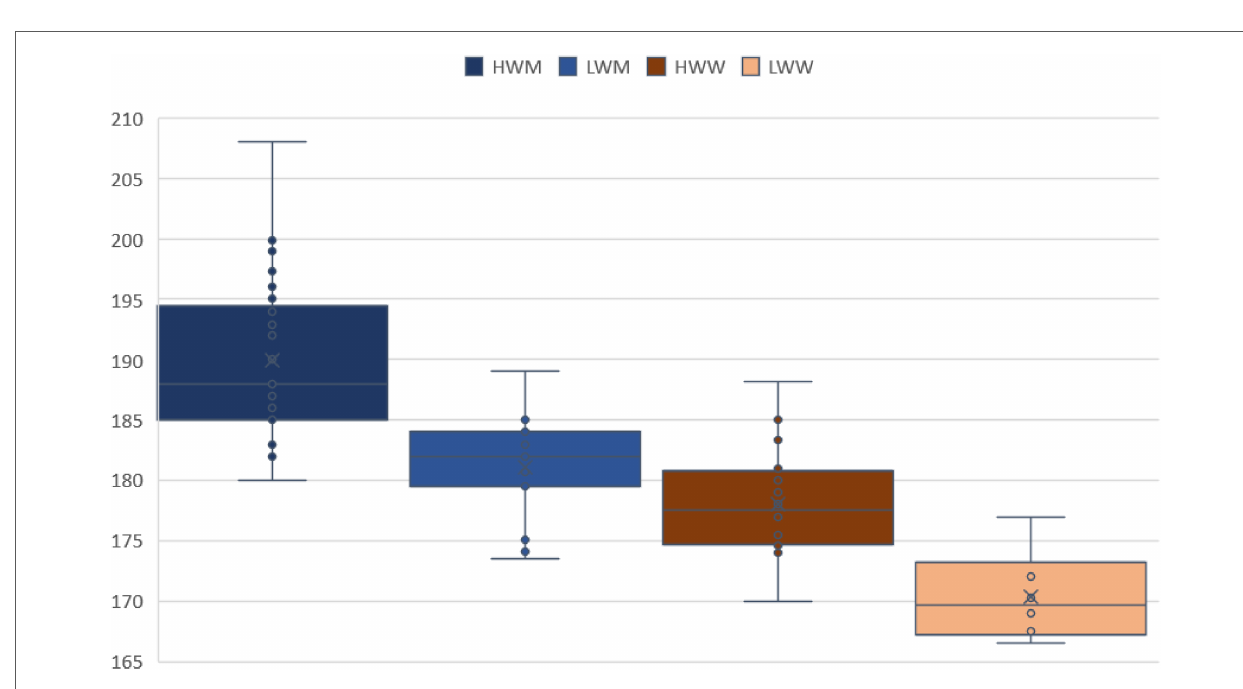
FIGURE 5 Differences in body height in male and female